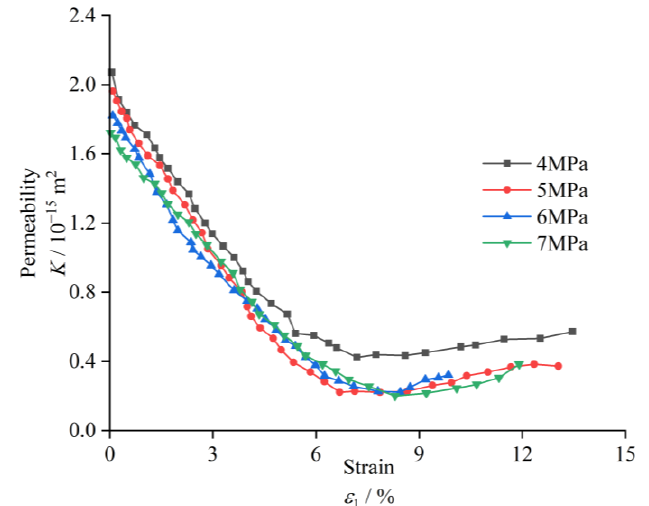
Figure 10. The permeability characteristic curve of coal sample under axial compression loading with a constant gas pressure of 1.5 MPa and different confining pressures.